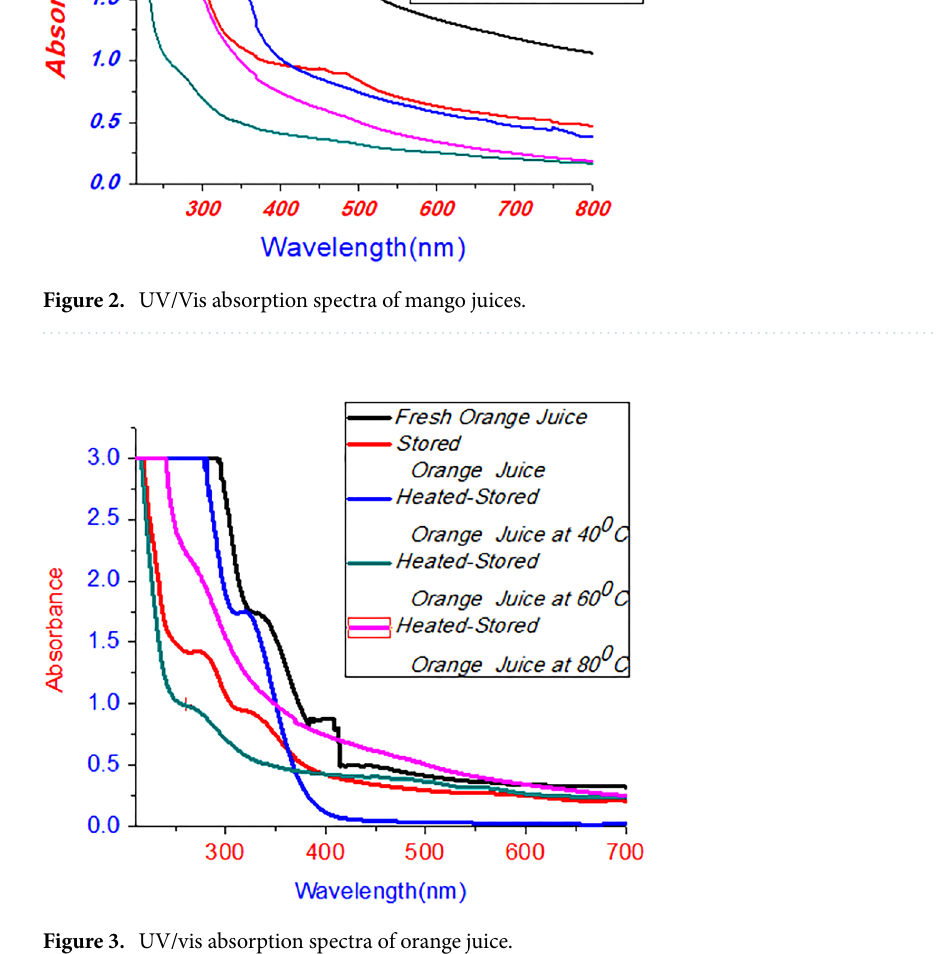
Figure 3 represents the UV/Vis absorption spectral of fresh, stored and heat-treated orange juices. The orange juices assimilation spectra were measured within the same methods as mango juices. The absorption peaks of fresh orange fruit were observed at 330 nm and 390 nm. Similarly, 260 nm and 326 nm represent the absorption spectra of stored orange juice. The peaks of absorption observed at a wavelength of 320 nm & 260 nm represent heat-treated or stored orange juices of 40 °C and 60 °C temperatures, respectively. There are no absorption peaks for the samples stored at a temperature of 80 °C. The absorption band found in the region of 260 to 280 nm represents vitamin C. Coumarin was found at an absorption peak of 330 nm. Coumarin could be a plant aux- iliary metabolite which has capable of stopping or slowing a specific biological process. Moreover, known to be a plant controller development. The absorption peak observed at 390 nm compares vitamin A whereas 450 nm shows carotenoids 20,23–25 . Comparison stored, fresh, and heat-treated mango fruit juices with several literatures